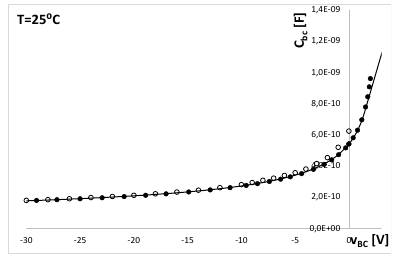
Fig.1. C bc (v BC ) characteristics of the BT1206-AC transistor at the ambient temperature equal to 25 °